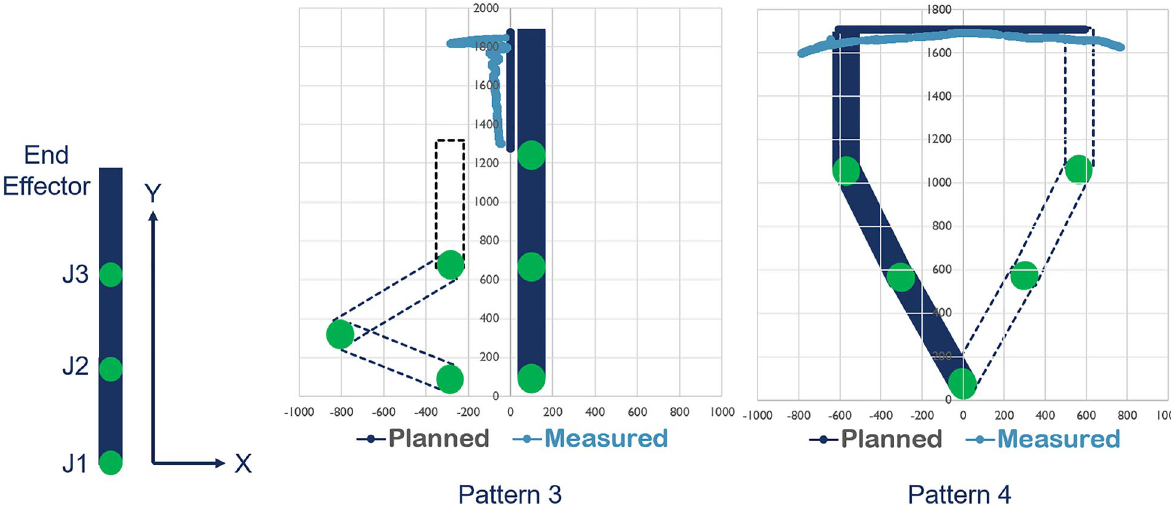
Fig. 5 End effector trajectory comparison results of Pattern 3 and 4. A The coordinate system in the image. B The result of Pattern 3. The position of the base joint is shifted in the X-direction to increase visibility. C The result of Pattern